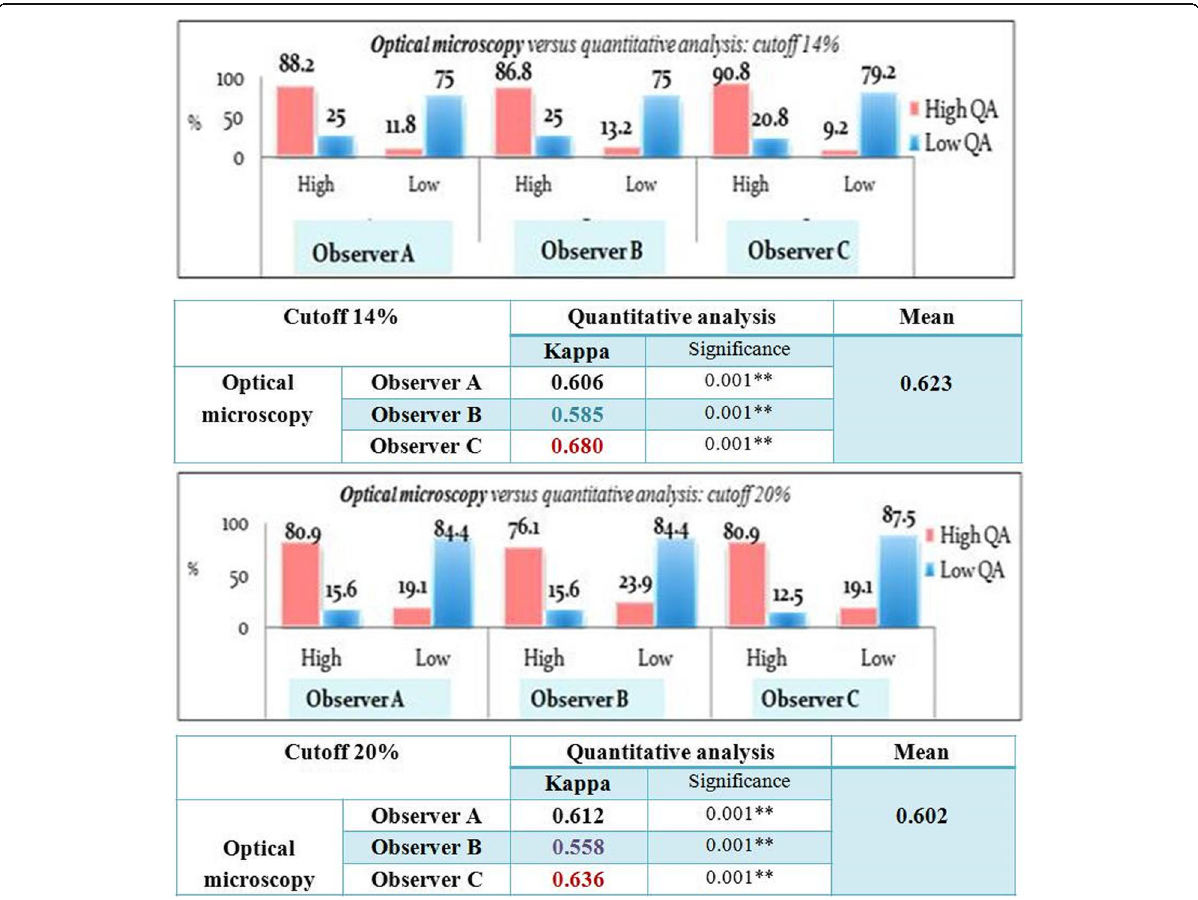
Fig. 4 Correlation between manual assessment of Ki67 on optical microscopy and automated assessment results using categorical